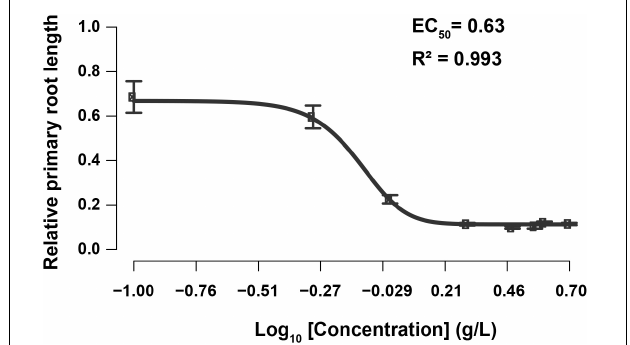
FIGURE 2 | Dose-response curve of relative primary root length to the increase of SBE concentration in the Arabidopsis root assay. Each data point indicates the mean ± SD ( n > 15). The black line represents the 5-parameter logistic regression. SBE, sunflower bark extract; EC 50 , half-maximal-effect